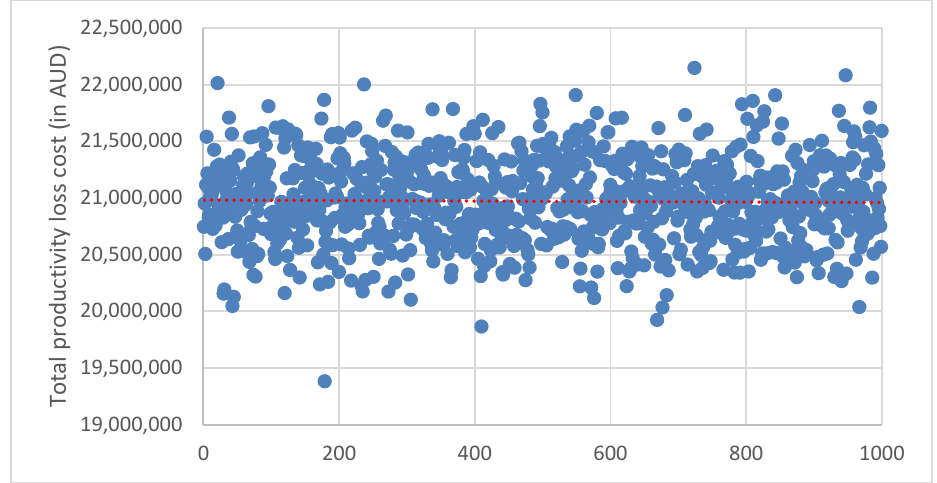
samples. Average presenteeism cost was AUD14.08 (95% CI: 14.10 – 14.07) million.